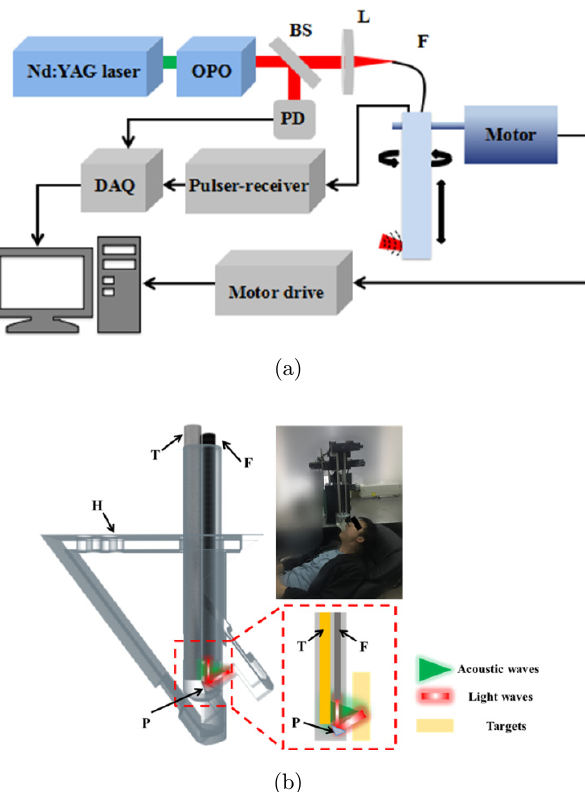
Fig. 1. (a) The schematic of the integrated system. OPO: Optical Parametric Oscillator, BS: Beam splitter, L: Convex lens, PD: Photodiode, F: Fiber, DAQ: Data acquisition system. (b) 3D rendering of the imaging interface (left), photograph of the volunteer receiving inspection (top right), and close-up view of the part indicated by the dashed rectangle in the imaging interface (bottom right). H: resinous holder, T: Transducer, F: Fiber bundle, P: